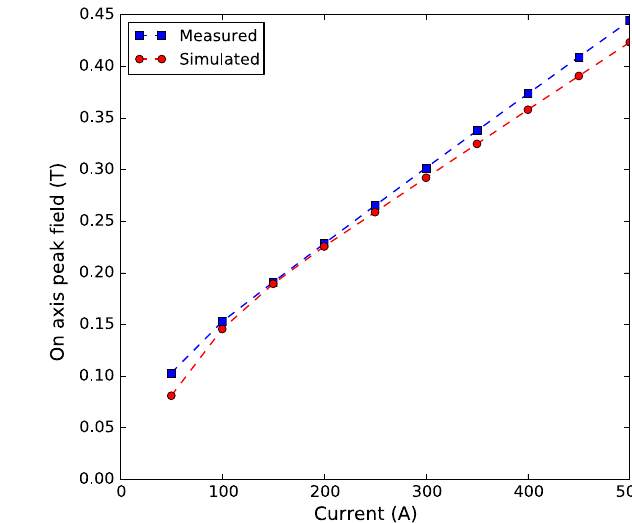
FIG. 29. Measured and predicted magnet excitation curves. The operating value of 0.41 T is reached at 450